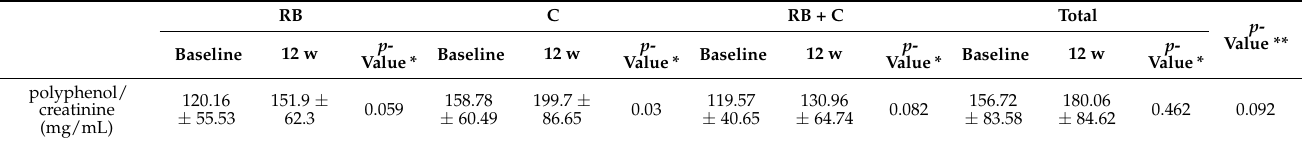
Table 5. Creatinine-corrected polyphenol levels in each group and by visit.